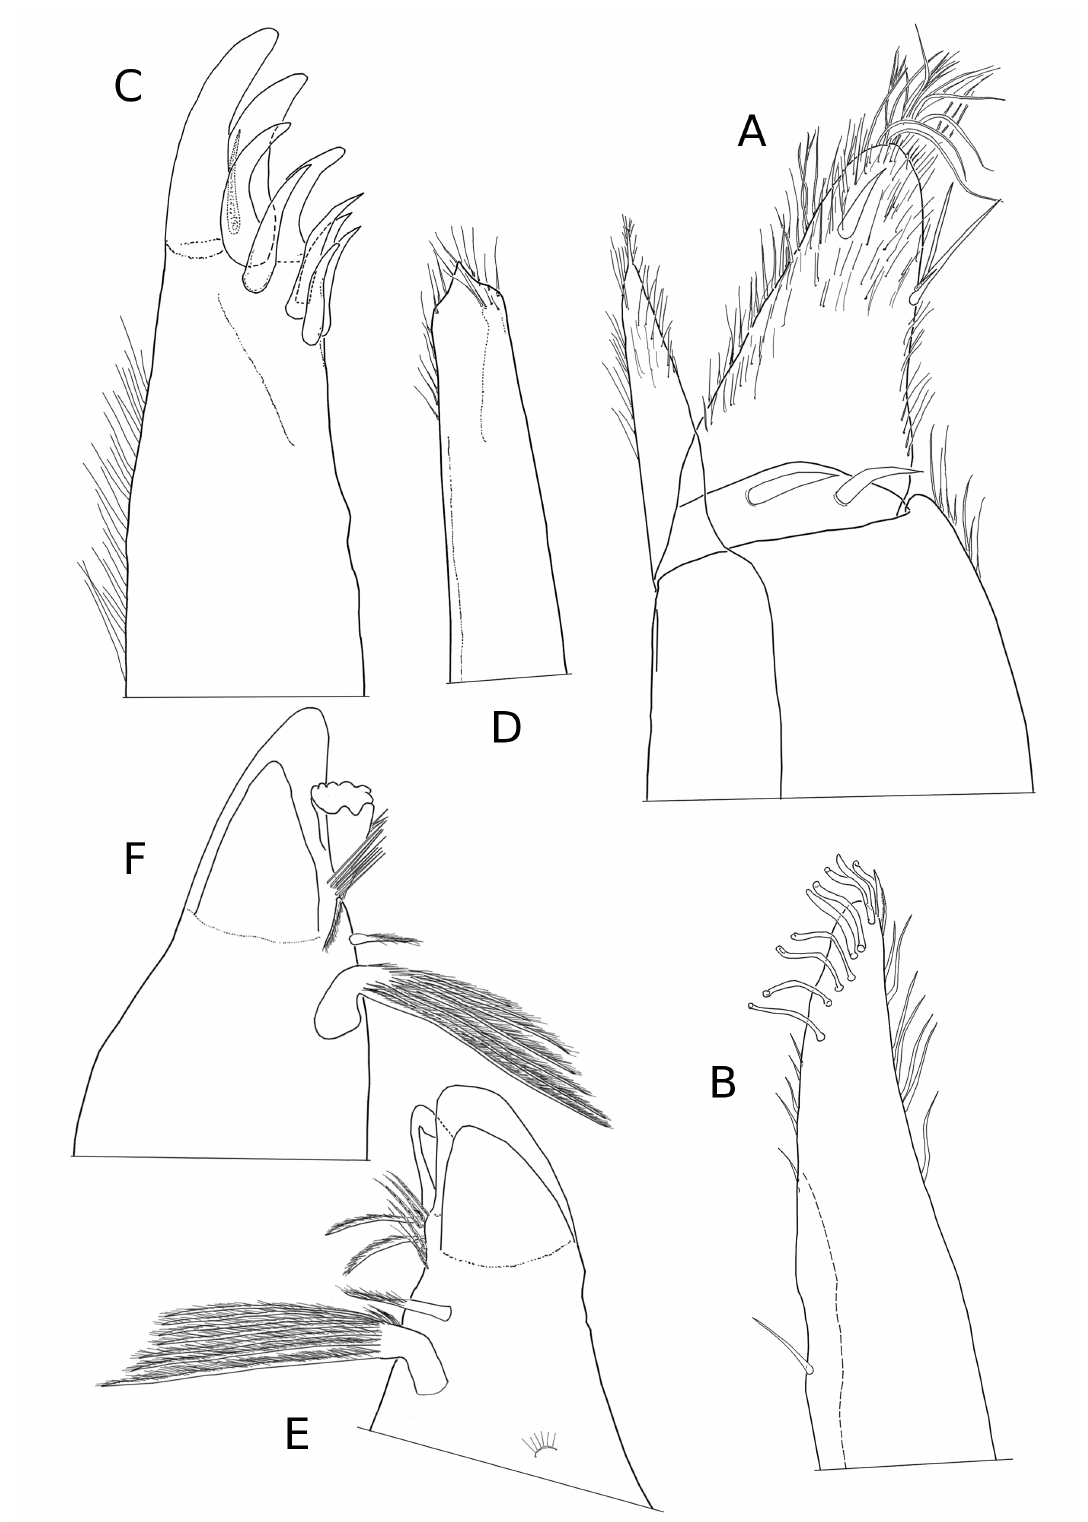
Fig. 5. Buchnerillo atlanticus sp. nov., paratype, ♂ (MBCN 24683). A . Distal part of maxilliped. B . Maxilla. C . Maxillula, outher branch. D . Maxillula, inner branch. E . Left mandible. F . Right mandible. Figure not to